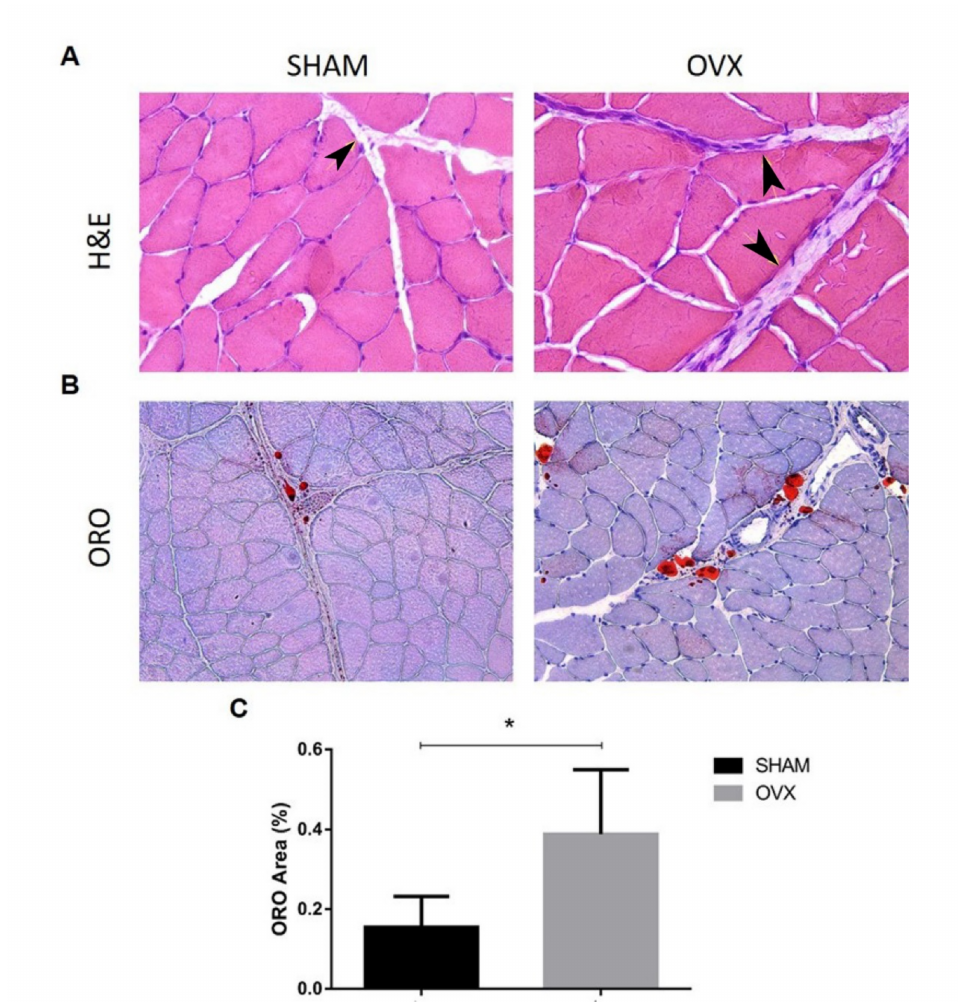
Figure 3. Morphological differences and fat infiltration of skeletal muscles in SHAM and OVX rats. ( A ) The OVX group presented more intramuscular fat tissue than the SHAM group by H&E taken at 20 × magnification, where fat tissues are indicated by black arrows. ( B ) The OVX group showed a higher ORO signal (red area) than the SHAM group. ( C ) Quantitative analysis revealed that the ORO area of the OVX group was significantly higher (* p < 0.05, Student’s T-test). The age of the participants was found to be negatively associated with HR-pQCT parameters, including MV (r = − 0.479, p < 0.01), IMAT/MV (r = 0.620, p < 0.01), MD (r = − 0.763, p < 0.05), and MCSA (r = − 0.479, p < 0.05), and positively correlated with IMAT% (r = 0.559, p < 0.01), all with statistical significance (Table 1). Age was also found to correlate with all muscle strength and performance outcomes, with a moderate to strong correlation detected with Pmax (r = − 0.608, p < 0.001) of the chair rise test, and both the quadriceps and hamstring strength (r = − 0.686 and r = − 0.638, respectively, both at p < 0.01, Table